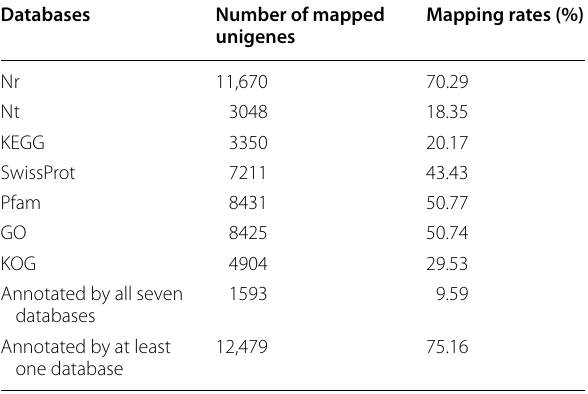
(Fig. 2; Additional file 1: Table S2). In the ‘Biological